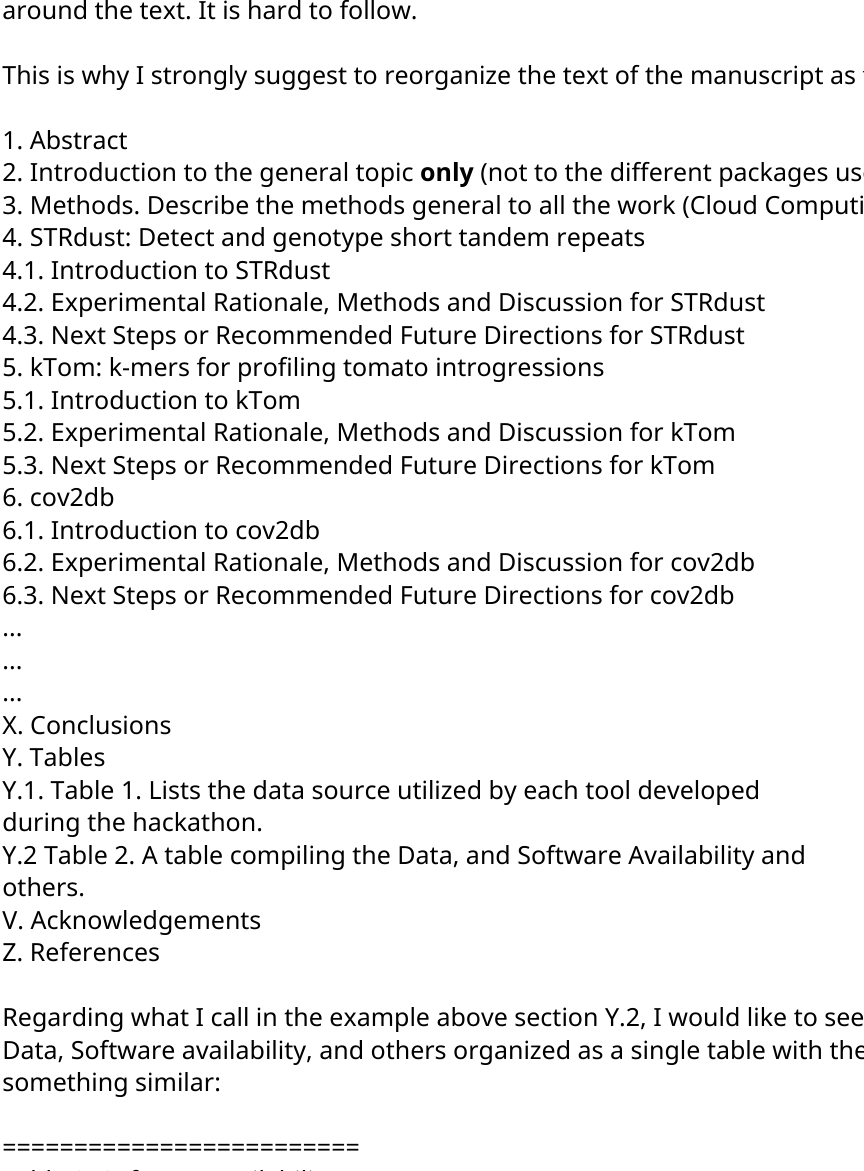
Table 2. Software